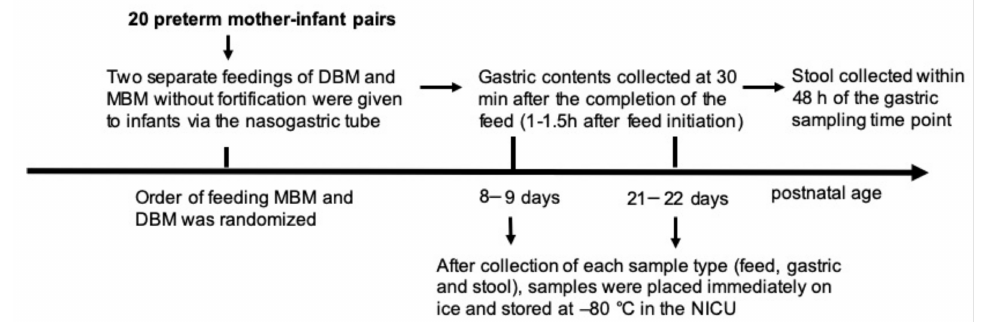
Figure 1. Schema of study design to determine the di ff erence of antenatal influenza-specific antibodies in mother’s breast milk (MBM) and donor breast milk (DBM) in gastric contents and stool samples from preterm